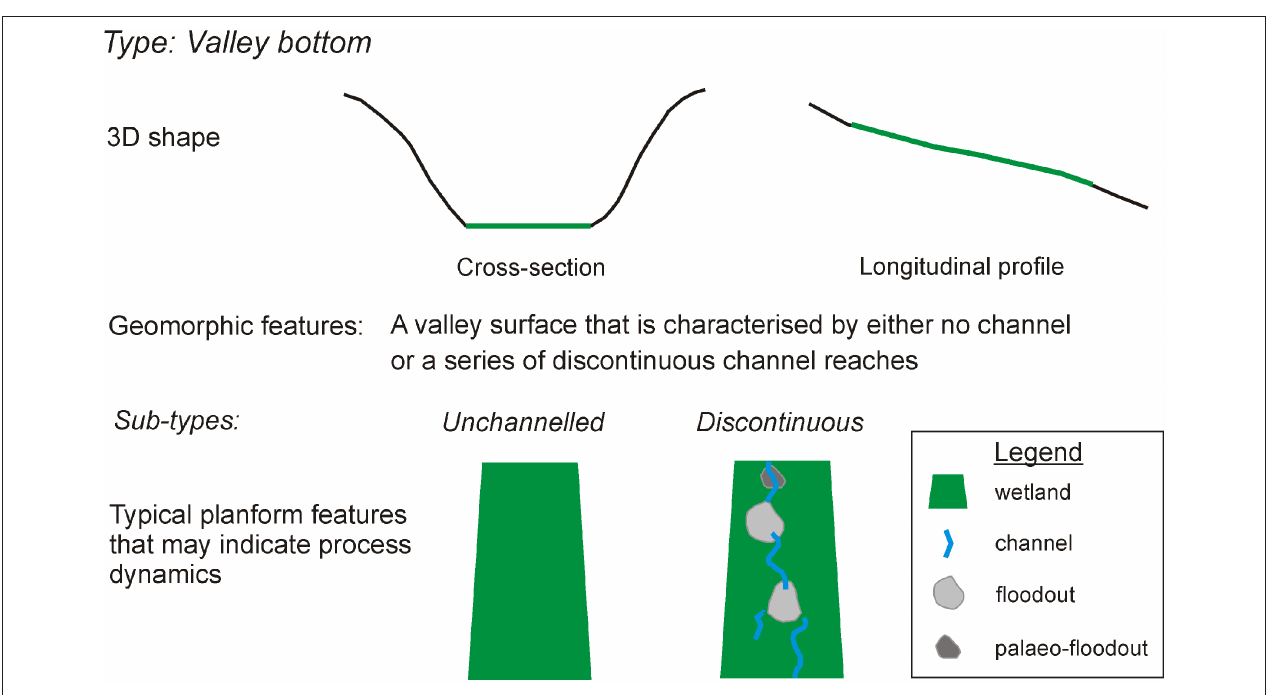
FIGURE 4 | Schematic shape and geomorphic features that are used to classify valley-bottom wetland type, followed by typical planform features that are process indicators used to classify unchannelled and discontinuous wetland